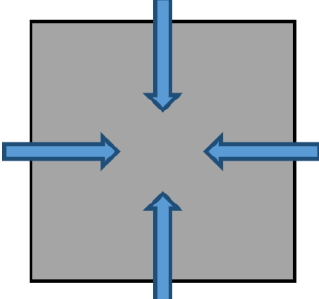
Figure 1. Concepts of gas diffusion under unipore diffusion (UD) Model [19].